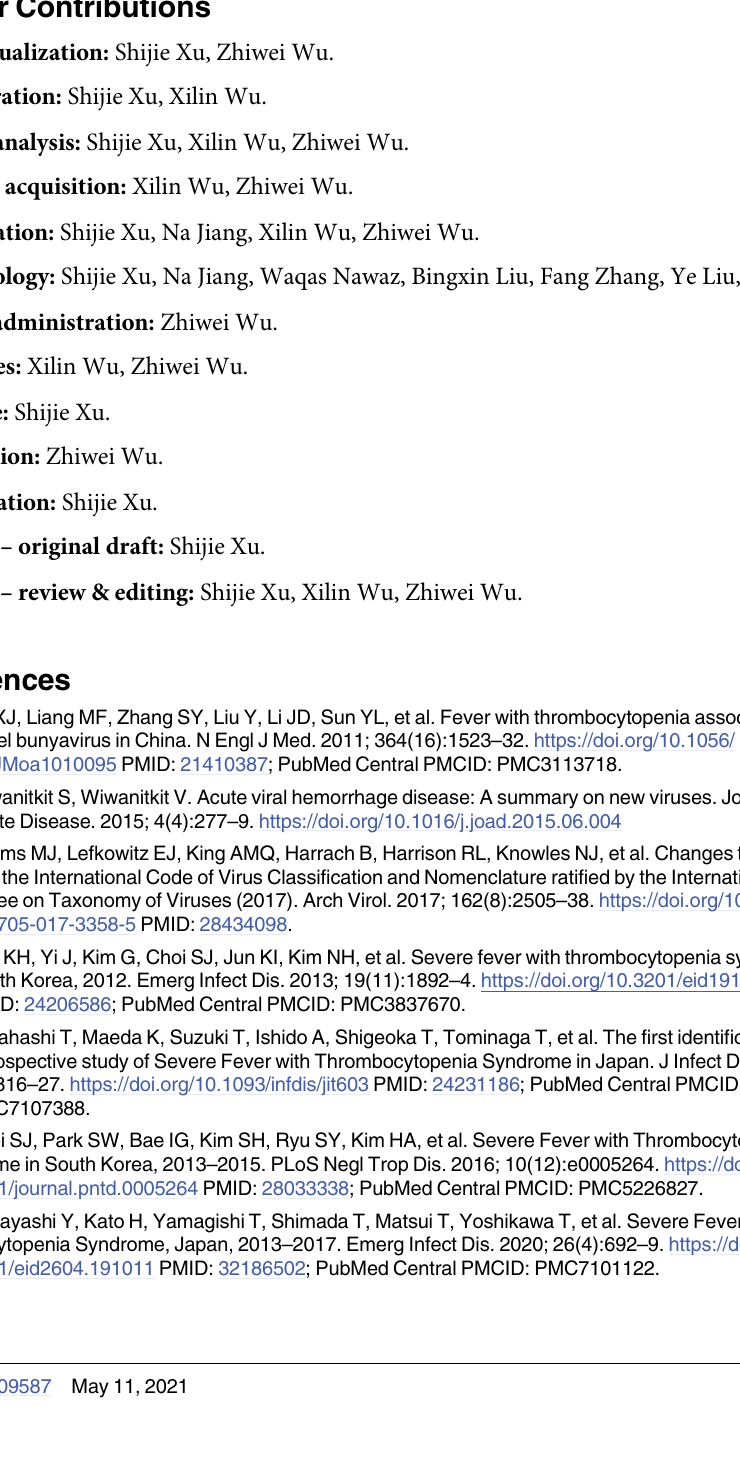
S7 Fig. CBA multi-human cytokines test. Anisomysin and Vitexicarpin decreased the plasma level of multi-human inflammatory factor. Data are shown as mean ± SEM of three indepen- dent experiments. � p <